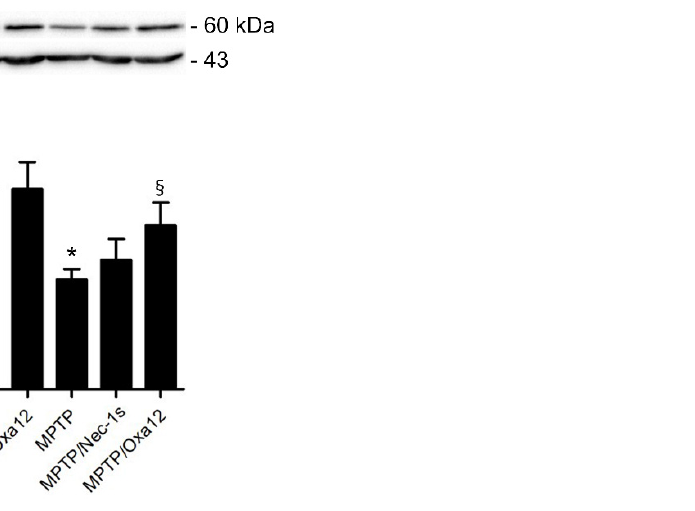
Figure 4. Oxa12 protects dopaminergic neurons from MPTP-induced cell death. Representative western blot of TH protein levels from control and MPTP-injected mice untreated or treated with Nec-1s or Oxa12 in the SN, and the respective densitometric analysis. β -actin was used as loading control. Values are expressed as mean ± SEM of three independent experiments. * p < 0.05 vs. control mice; § p < 0.05 vs. MPTP mice. TH, tyrosine hydroxylase.